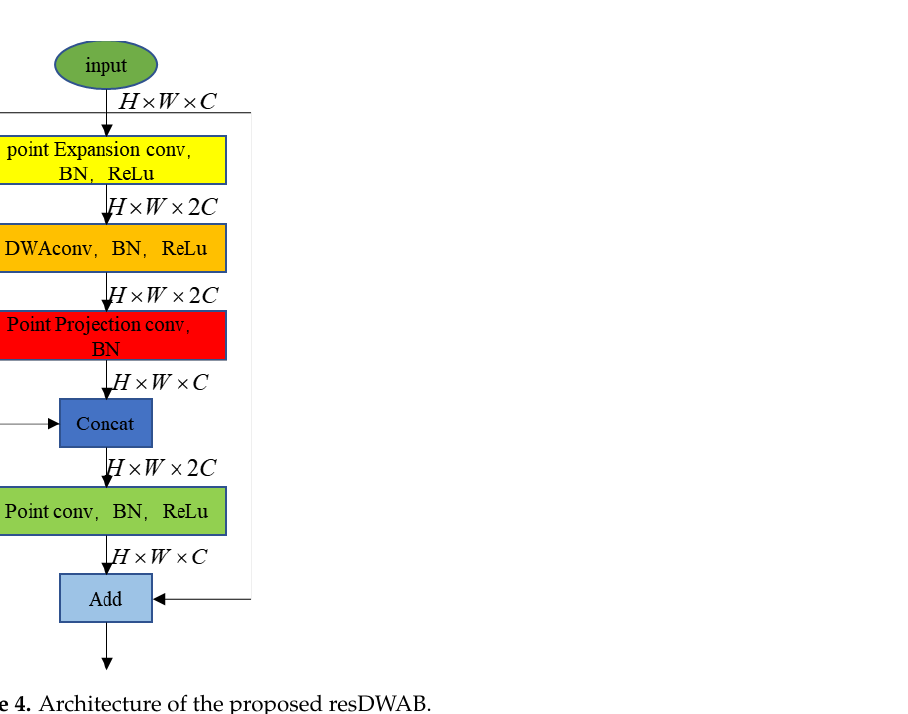
Figure 4. Architecture of the proposed resDWAB.